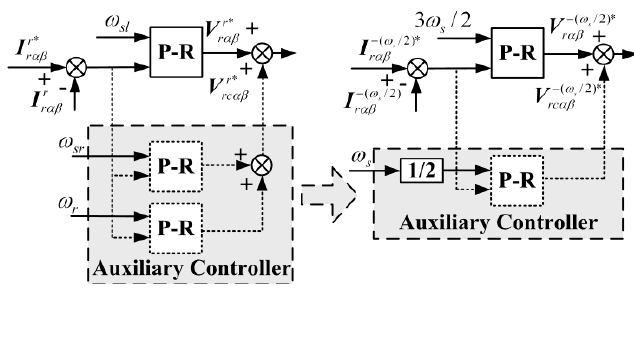
Figure 9. Simplification of the PR controller.